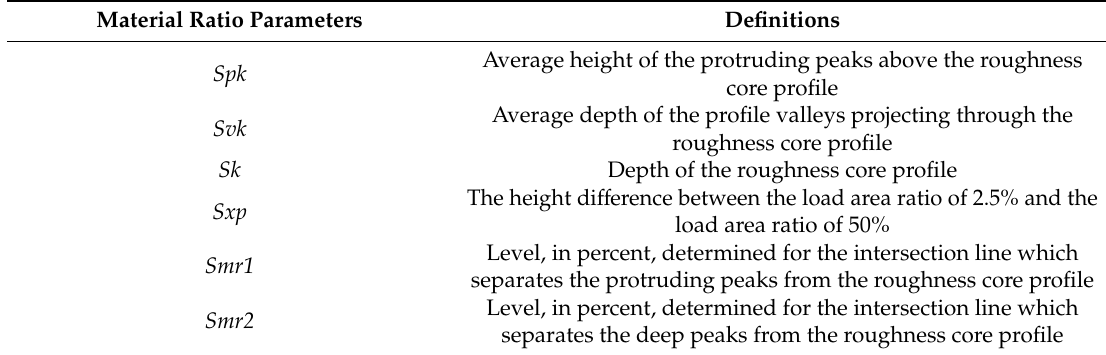
Table 5. Nomenclature and definition of bearing area ratio parameters.